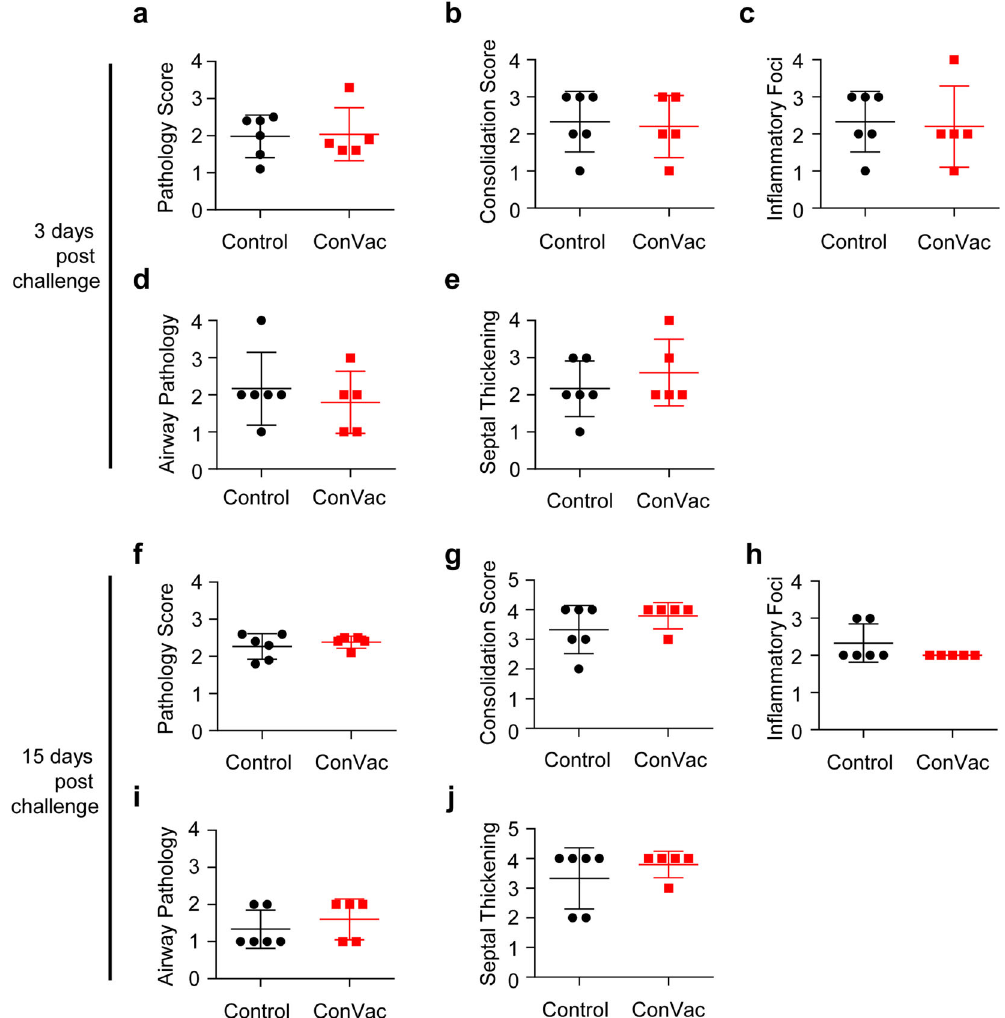
Fig. 7 Comparative pathology scores for lungs from vaccinated and control hamsters post SARS-CoV-2 challenge. Scores at three days ( a - e ) and 15 days ( f – j ) post challenge. Scores for overall lung pathology ( a , f ), and individual criteria, including consolidation or extent of in fl ammation ( b , g ), type of in fl ammatory foci ( c , h ), airway pathology ( d , i ) and septal thickening ( e , j ), are displayed. The pathology scores (mean) were calculated based on the criteria described in Supplementary Table 1. The ConVac vaccine group is shown in red and the control group in black. Data represent mean ± SD, N = 6 for control group and N = 5 for ConVac vaccine group at each time obtained with other vaccine candidates, including the mRNA vaccines BNT162b2 from P fi zer 23 and mRNA-1273 from Mod- erna 25 . We note that two vaccinated animals were euthanized on days 10 and 11 after immunization (i.e., prior to the SARS-CoV-2 challenge) due to a disease of unknown etiology; however, we cannot completely exclude a residual neurovirulence of VSV G at the high, 2 × 10 7 FFU, vaccine dose used in our study. SARS-CoV-2 viral loads determined by plaque assay in lung tissues were signi fi cantly reduced in ConVac-vaccinated animals compared with controls, with only one vaccinated hamster having detectable viral loads on day three, suggesting that the ConVac vaccine prevents or strongly reduces SARS-CoV-2 replication in the lower respiratory tract. The hamster with the detectable viral load on day three had the lowest neutralizing antibody titer. Viral loads in the nasal turbinate tissues of vaccinated hamsters were reduced compared with control animals, but the difference was not statistically signi fi cant due to the limited number of animals per group and high variability between samples. Viral RNA levels determined by RT-qPCR con fi rmed these fi ndings of a more robust protection in the lung compared with the nasal turbinates.